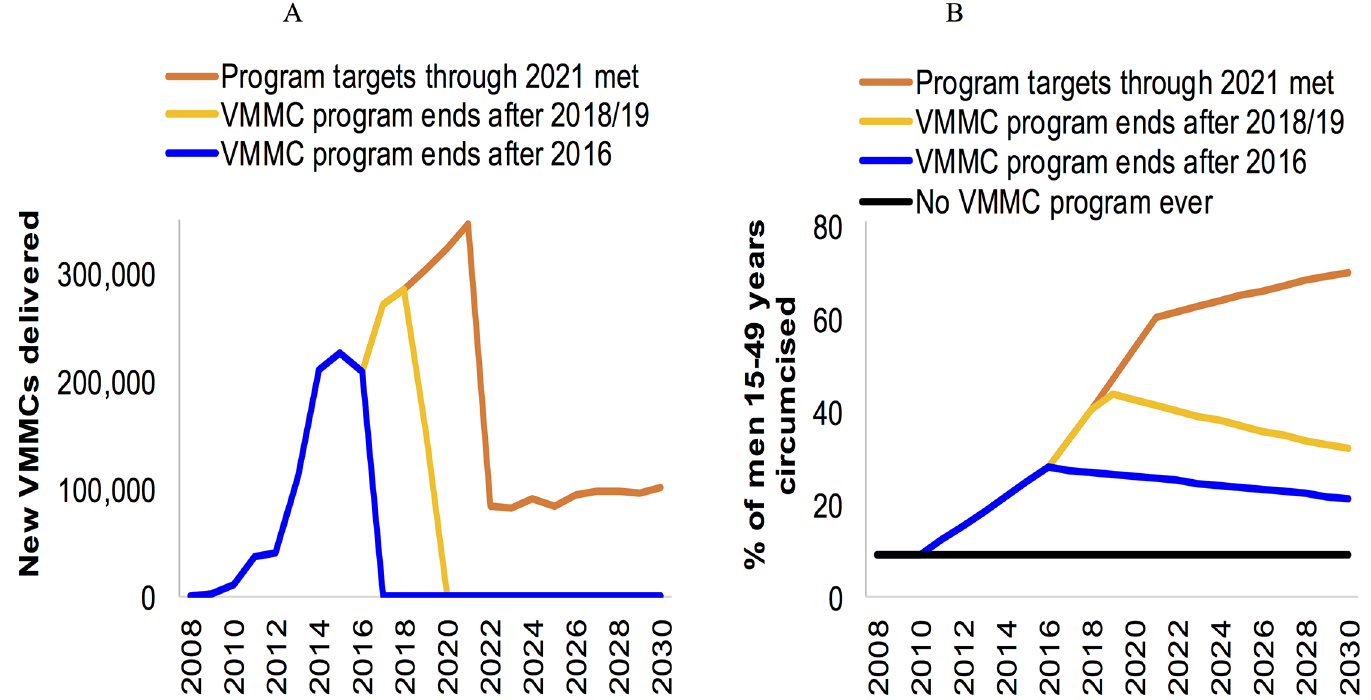
Fig 1. Modeled circumcisions. (A) Number of new VMMCs occurring each year and (B) the resulting percentage of men ages 15–49 who are circumcised, by scenario. The 2009–2016 new VMMCs are from program data; the 2008–2009 circumcision coverage was the modelers’ estimate based on the 2005 and 2010 DHS. The projected results (VMMC numbers and circumcision coverage over 2010–2030) shown here are from the Goals model; the ICL and EMOD models projected similar numbers (see Table 2) and coverages (not shown).